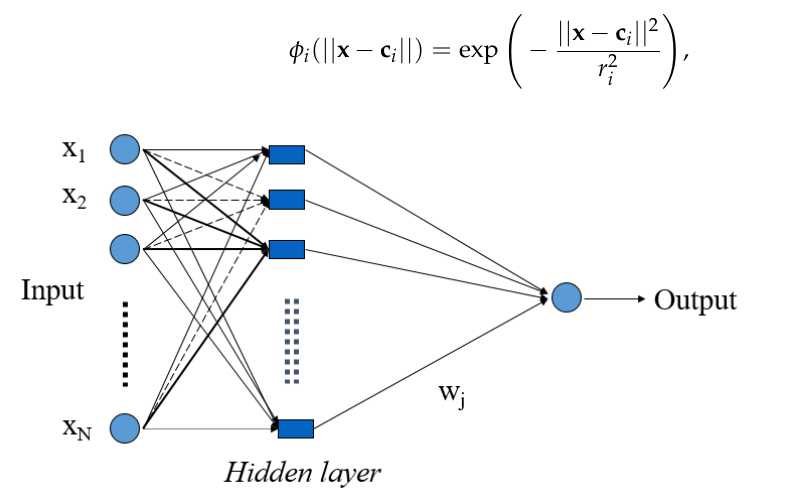
Figure 2. Radial basis function model network